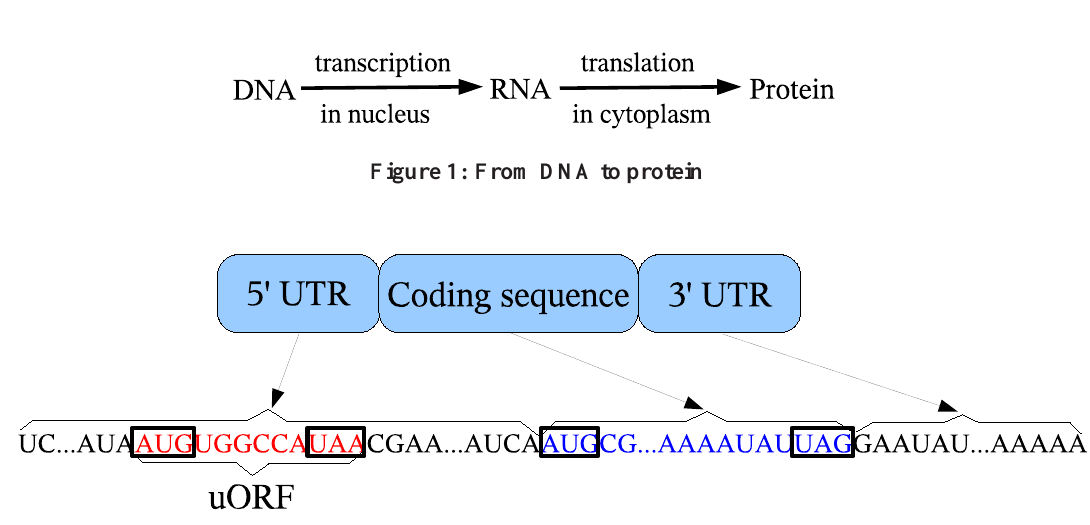
Figure 2: Simplification of mRNA structure. A, U, G, and C are RNA’s bases. A codon is a triplet of bases. AUG is the start codon. A stop codon can be UAA, UAG, or UGA. A 5 0 UTR may have zero or more